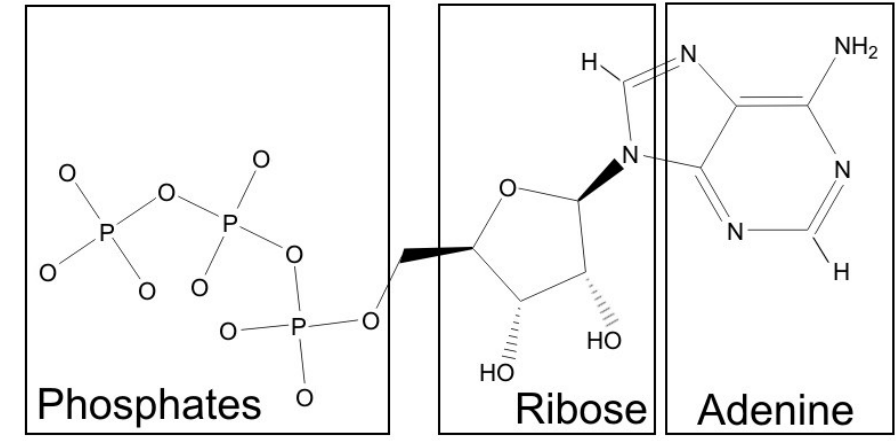
Figure 1. Dissection of the ATP molecule into fragments based on atomic hydrophobic/hydrophilic properties. The fragments identified by an automated procedure correspond well to the intuitively distinguished parts: a hydrophobic adenine ring with the attached amino group, a slightly hydrophilic ribose moiety and a distinctly hydrophilic phosphate